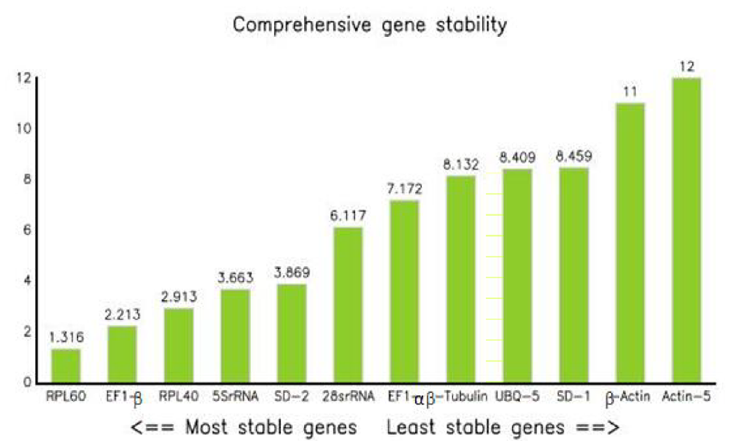
Fig 5. Expression stability of 12 candidate reference genes calculated by